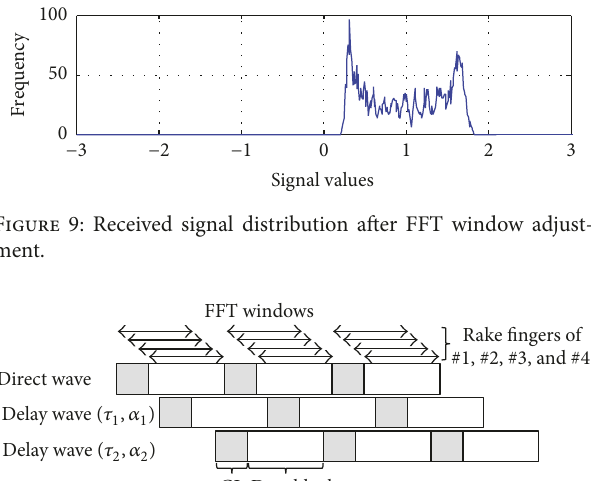
Table 1: Results of delay